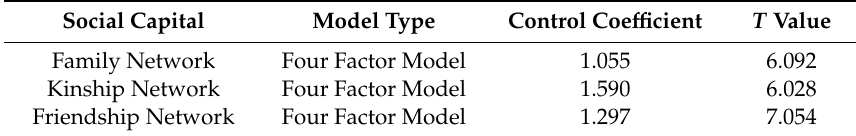
Table 3. The moderating e ff ect of socioeconomic status.